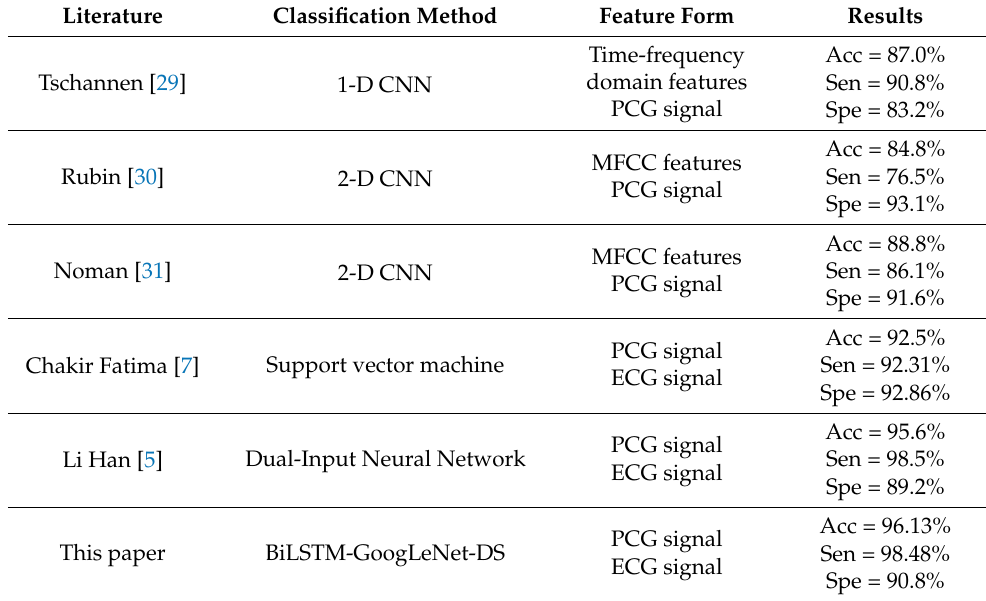
Table 4. Comparison between this algorithm and other algorithms in the literature. Literature Classification Method Feature Form